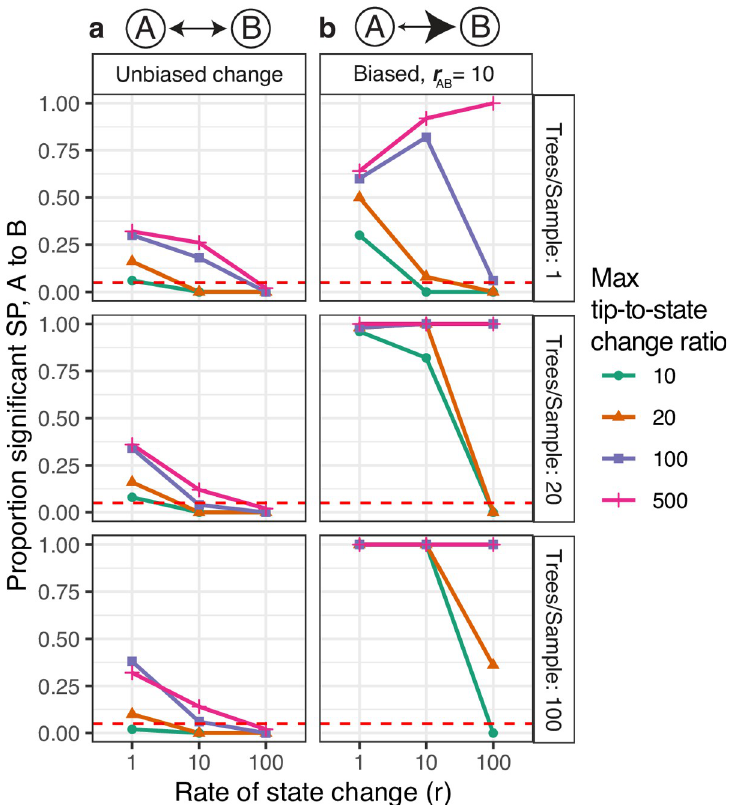
Fig 4. Controlling false positive rates using down-sampling. Y axis shows the proportion of 50 simulation replicates in which the SP test from A to B was significant. Simulations were performed on large ladder phylogenies ( Methods ) at varying rates, biases, and trees per repetition (representing lineages within a simulated repertoire). In each case, simulated lineages were down-sampled to the specified maximum tip-to-state change ratio. (a) Unbiased simulations, significant SP test values indicate false positives. These show that the SP test has a high rate of false positives when the rate of state change is low (i.e. 1 change/mutation/site) and the maximum tip-to-state change ratio is high ( > 20). Down-sampling lineages to a maximum tip-to-state change ratio of 10–20, however, controls this false positive rate. (b) Simulations with rates biased from A to B , in which significant SP test values indicate true positives. These results show that down-sampling does not simply reduce power. However, power is lowered when the switching rate is high ( > 100) or the number of trees/repertoire is low ( <